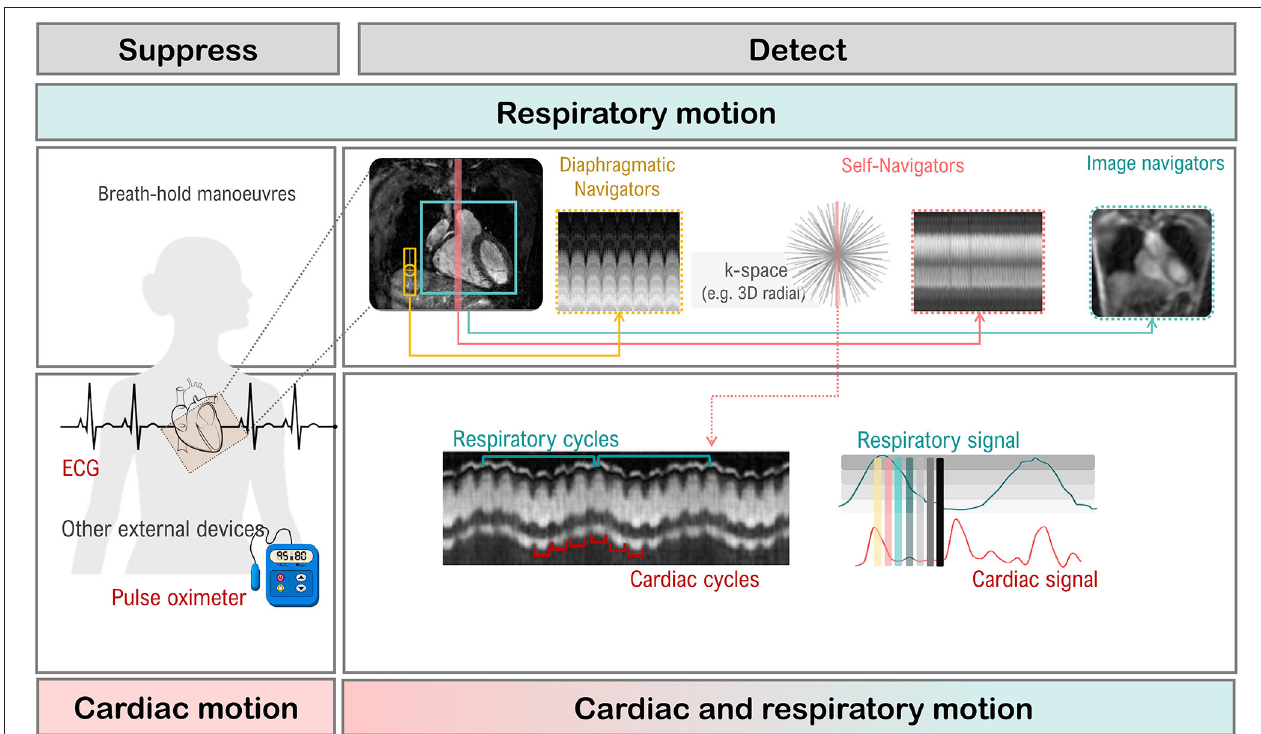
FIGURE 11 | Cardiac and respiratory motion monitoring. Motion can either be suppressed (e.g., breath-holding) or monitored with MR navigators or external devices like electrocardiogram (ECG). From the monitored signal, one can extract the respiratory, and cardiac cycles which are needed for triggering (prospective) or gating